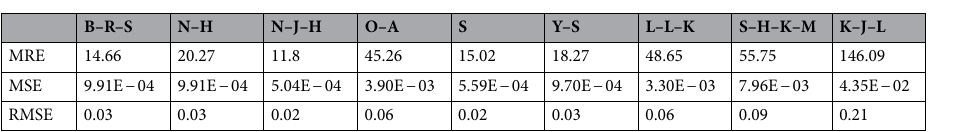
Table 3. The statistical parameters of previous